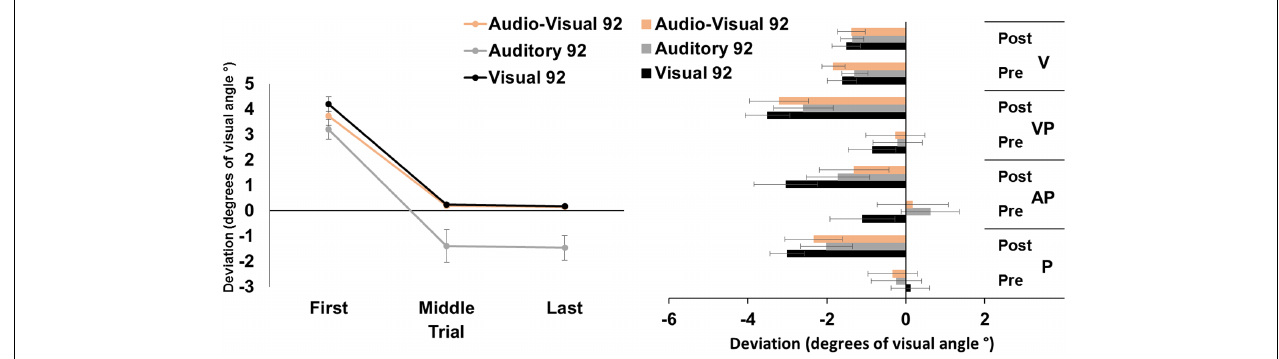
FIGURE 1 | Results from Experiment 1. (Left) Mean (Standard Error, SE) deviation of the pointing movements (average of first, middle, and last four pointings) of the right index finger from the target in the 92-pointings adaptation task in the visual (black), auditory (gray), and audio-visual (orange) conditions, in degrees of visual angle ( ◦ ); positive values correspond to rightward deviations from the targets, negative values to leftward deviations. (Right) Mean (SE) deviation from the body midline in the proprioceptive (P), auditory-proprioceptive (AP), visual-proprioceptive (VP), and visual (V) straight-ahead tests, before (pre), and after (post), the visual (black), auditory (gray), and audio-visual (orange) conditions of adaptation, in degrees of visual angle ( ◦ ); positive values correspond to rightward deviations from the perceived body midline, negative values to leftward